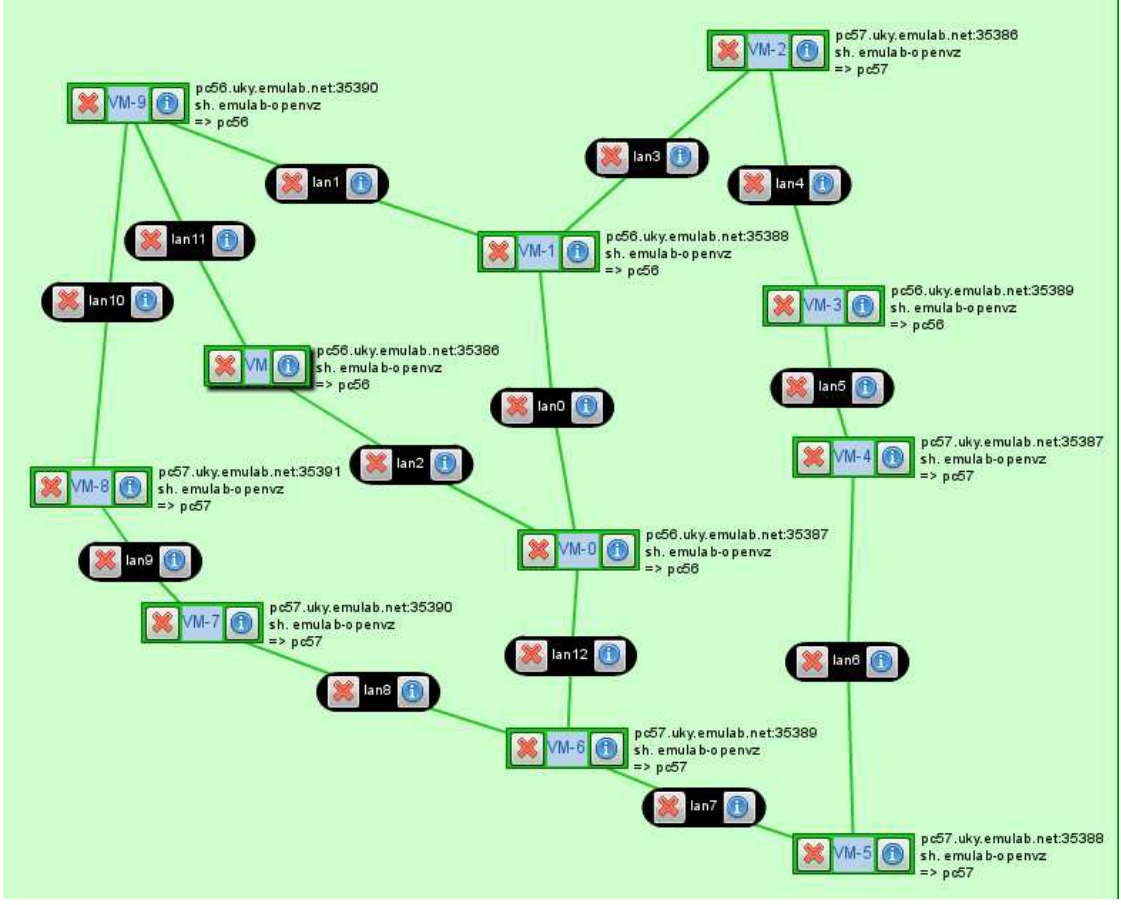
Figure 1. The single-aggregate